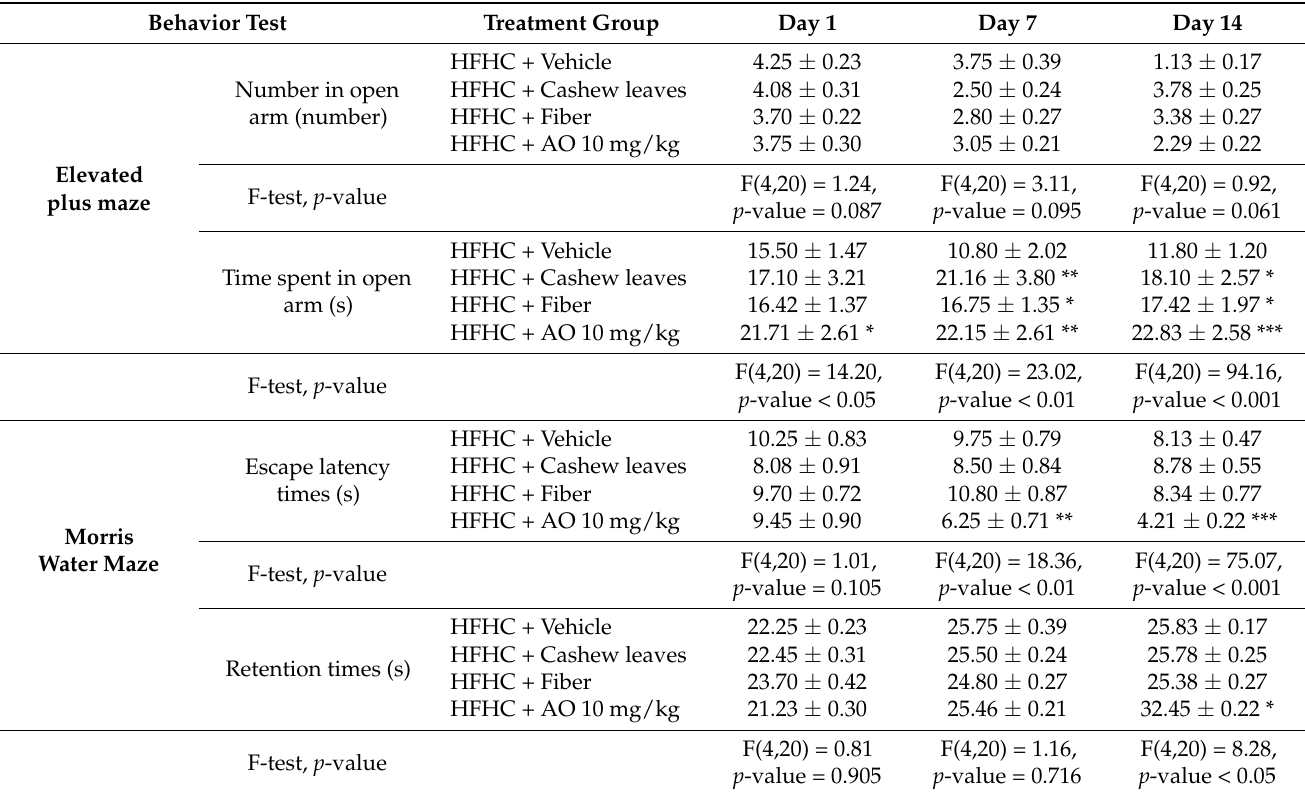
Table 7. Effects of the leaf extract, fruit pomace-derived dietary fiber, and the functional ingredient from A. occidentale on anxiolytic activity and memory-enhancing effect.